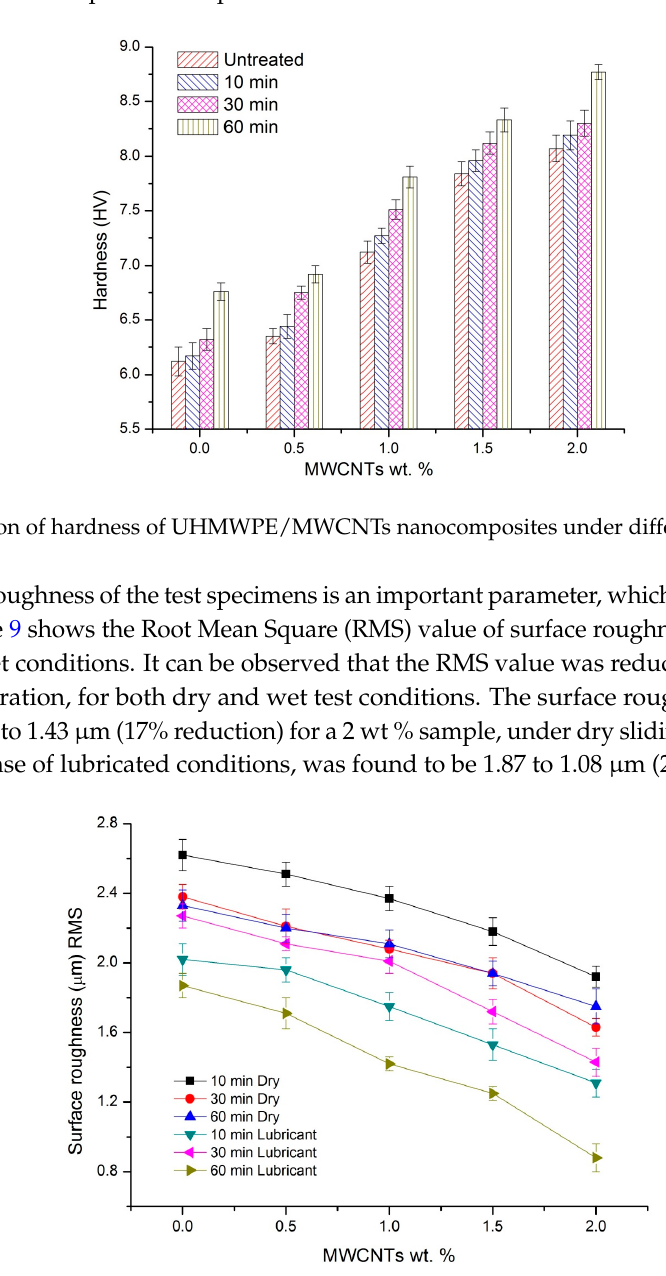
Figure 9. Surface roughness (RMS) value of nanocomposites under dry and lubricant conditions for different treatment times.